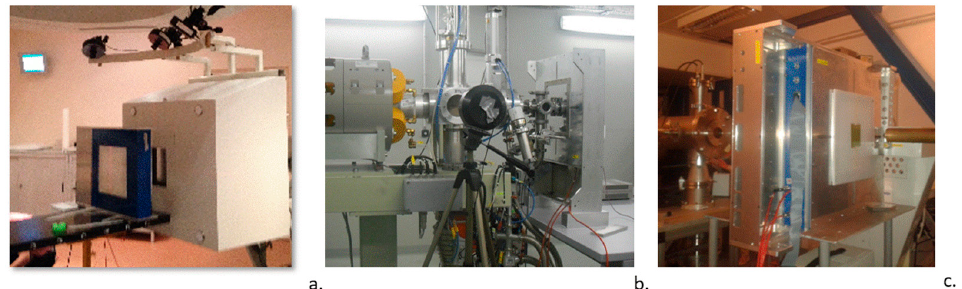
Figure 2. Pictures of the experimental setup for the MGD tests at the end of the Beam Transport